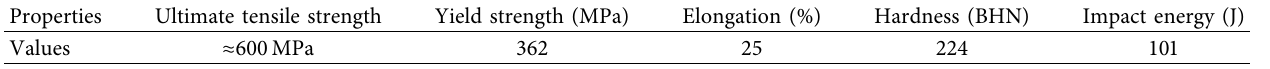
Table 1: Physical properties of 1020 (0.21%-C) steel [3].